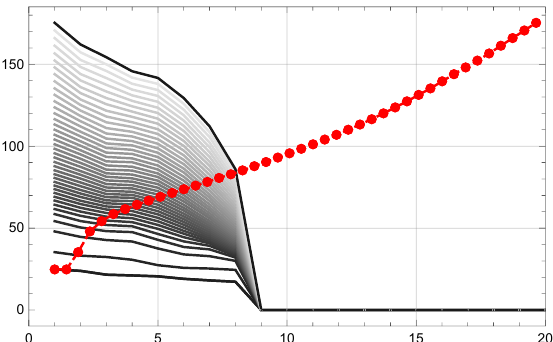
Figure 14 . Evolution of the eigenspectra of the symmetrised weight matrix for the first layer of our neural network. This network corresponds to the top neural network in figure 2, and outputs the eigenvalues of the flat metric on the Fermat quintic. There is one curve for each epoch. The x -axis corresponds to the top twenty eigenvalues. The y -axis gives its numerical value. The topmost curve corresponds to the beginning of training, and the bottom, the end. The curve in red tracks the largest eigenvalue from the spectra at each epoch. We note a certain monotonicity in this figure, in that the largest eigenvalue as well as the overall spectra lowers as training progresses.